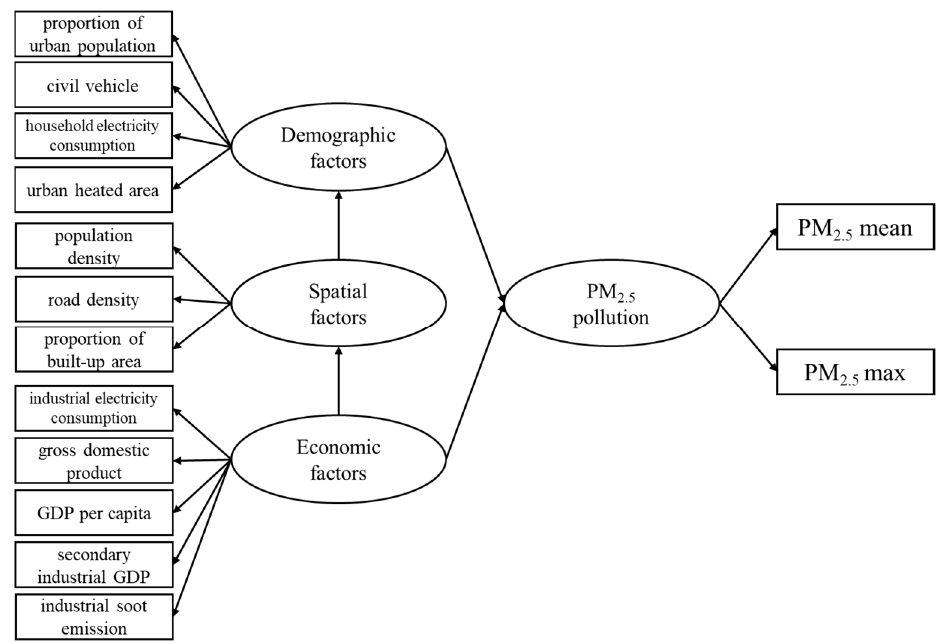
Figure 1. Initial frame for the SEM model. Variables in rectangles are observed variables; variable in ellipse are latent variables.